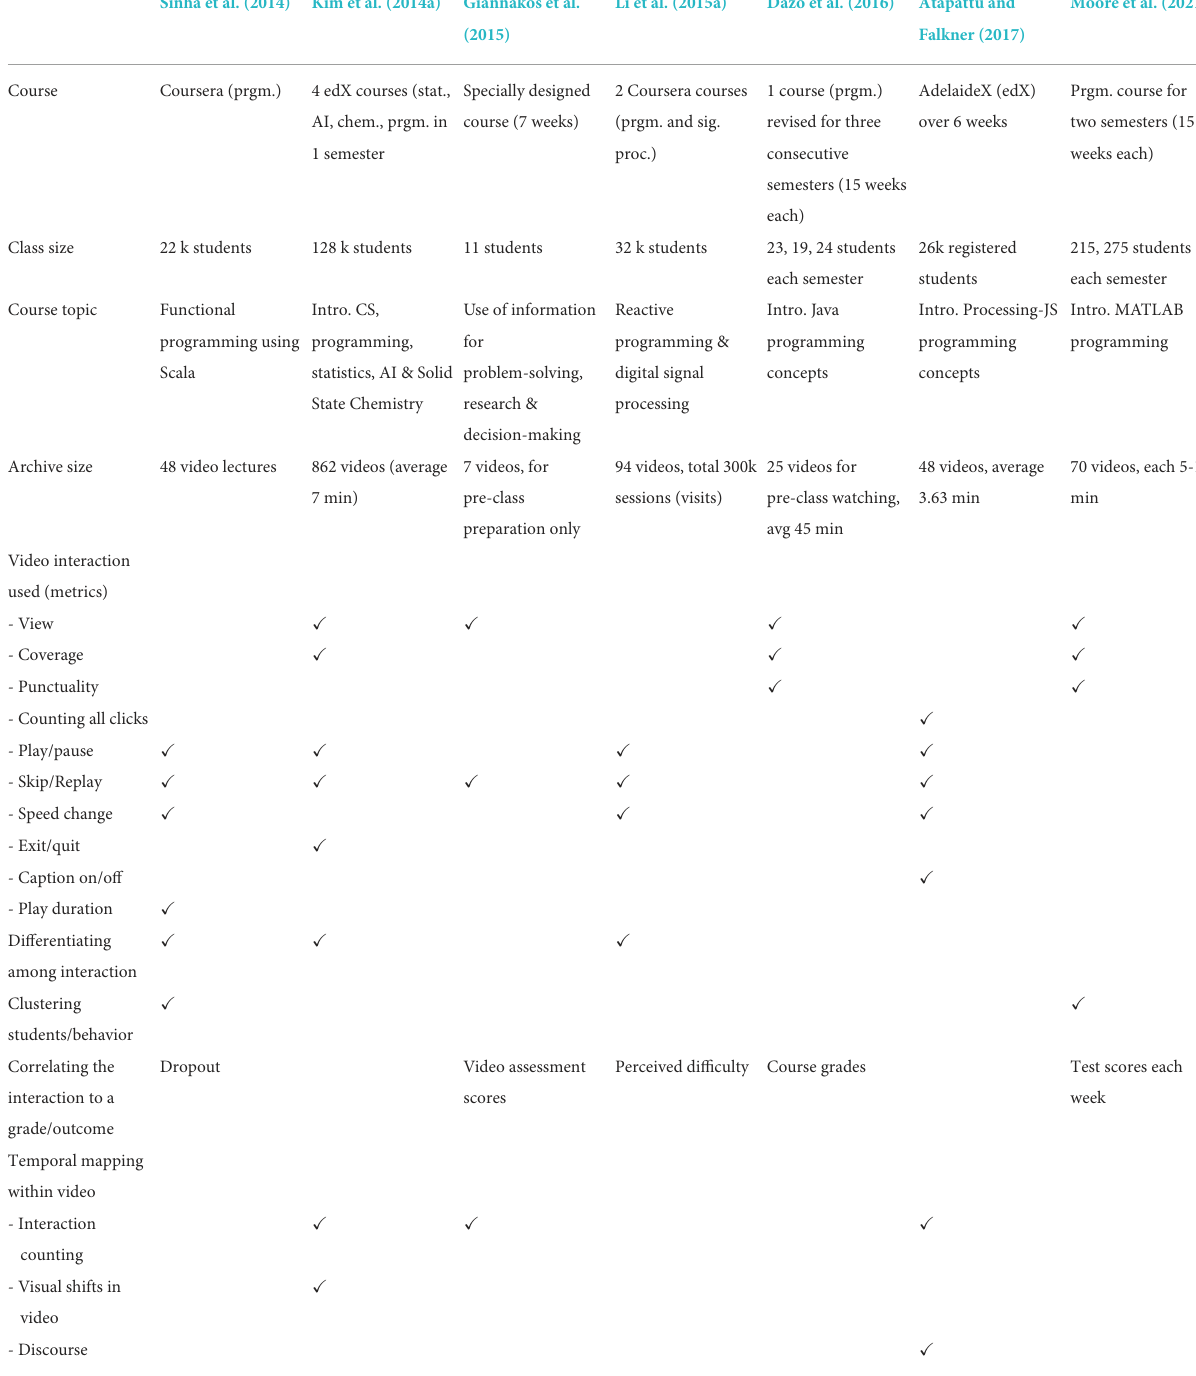
TABLE 1 Comparison table amongst seven representative analysis studies of educational video usage (this table shows only those metrics used and applied as the main focus of the investigation in each study). Sinha et al. (2014) Kim et al. (2014a) Giannakos et